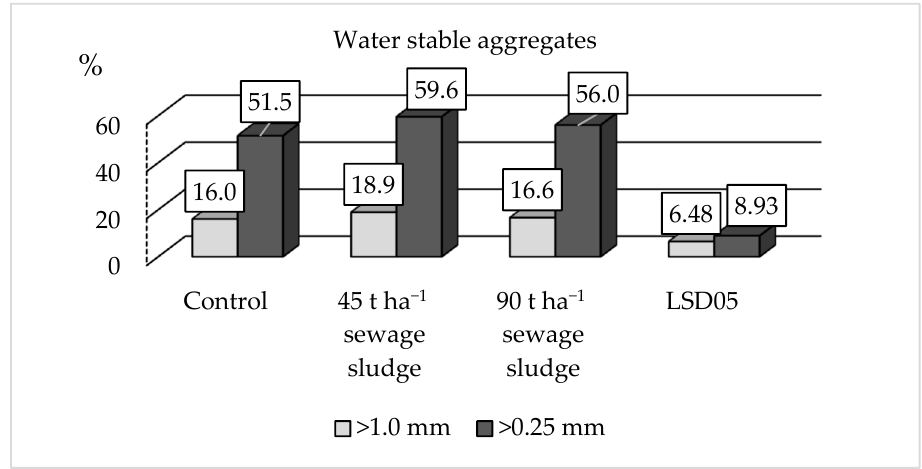
Figure 1. The dependence of soil water-stable aggregates on the fertilization type at the common osier growing site. Average data for 2015 and 2017.